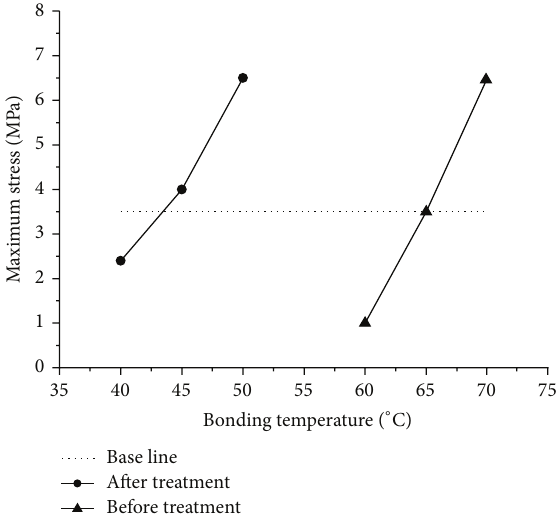
Figure 6: Bonding strength and temperature comparison